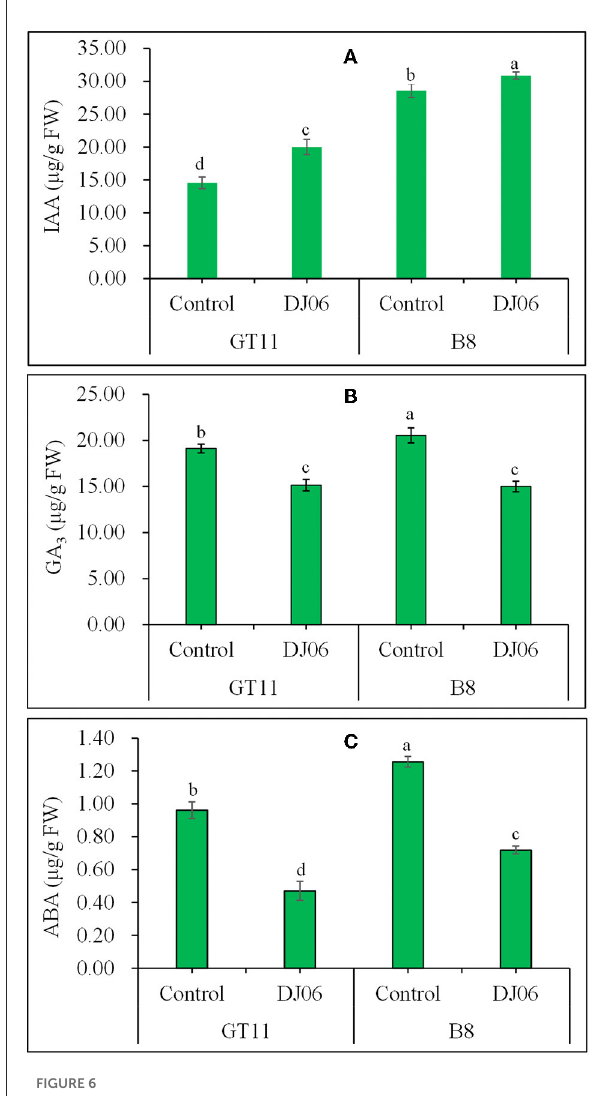
FIGURE6 The endogenous hormones in sugarcane varieties GT11 (A) and B8 (B) 60 days after inoculation with Pseudomonas aeruginosa DJ06 compared with the control. (A) IAA; (B) GA 3 ; (C) ABA. The same letter indicated that no significant difference was detected at Duncan’s multiple range test, P ≤ 0.05 ( n =